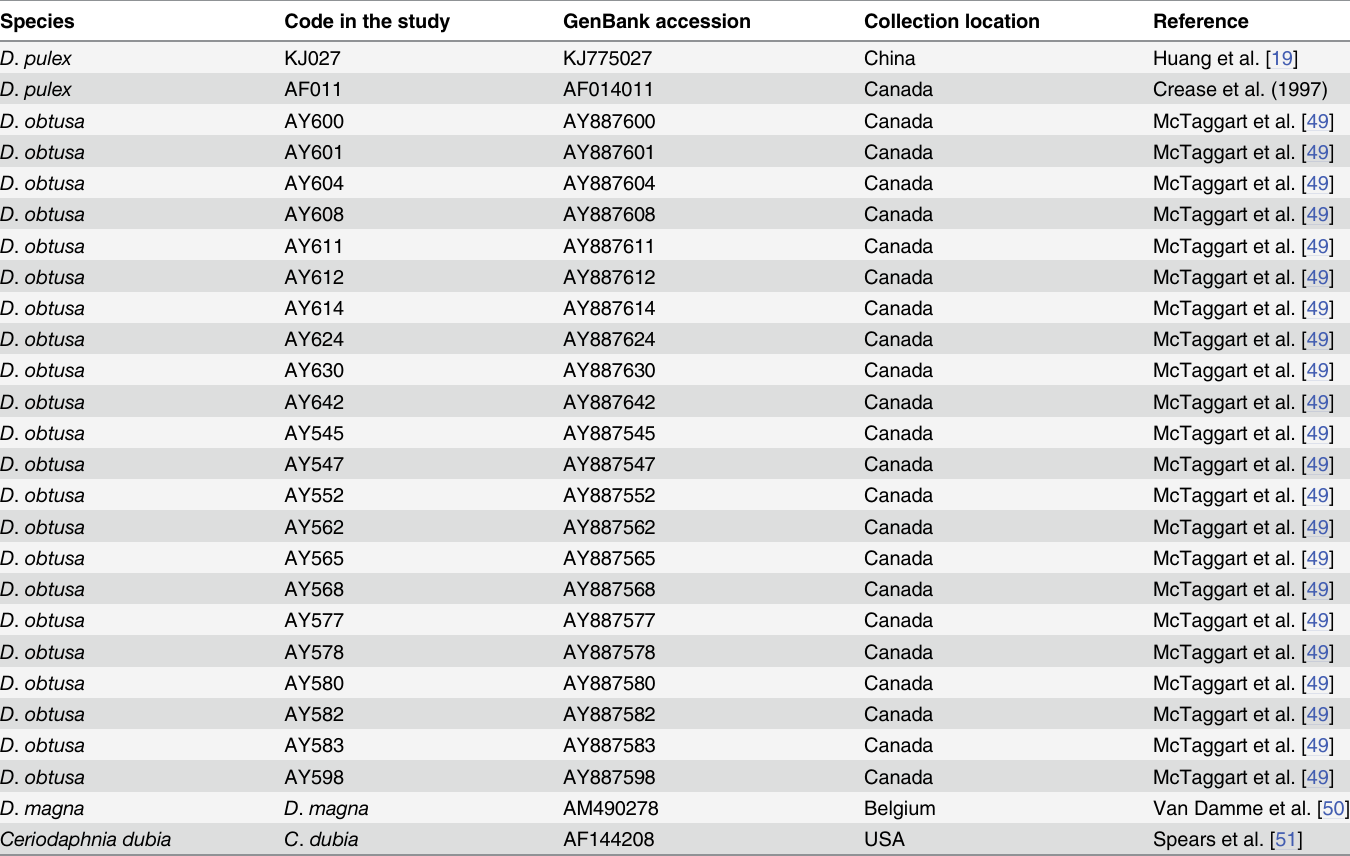
Table 4. 18S gene sequences of Daphnia and Ceriodaphni a from